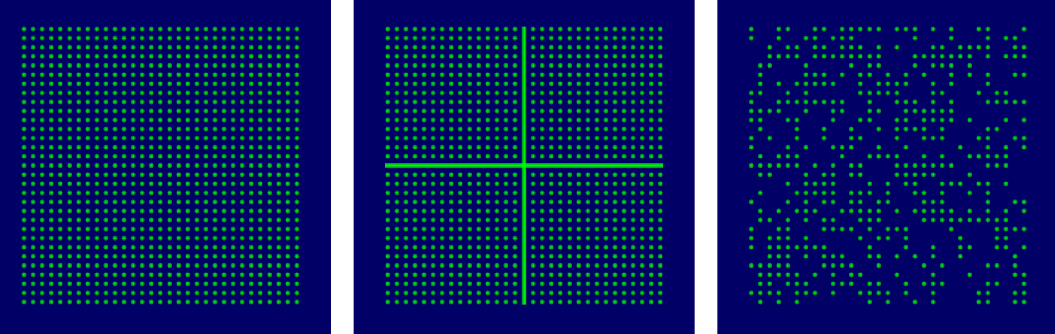
Figure 18. Different designs for laser projection grid: regularly structured grid ( left ), regularly structured grid with cross hair ( middle ), randomly structured grid ( right